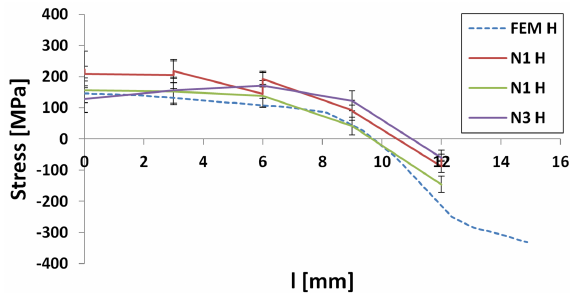
Figure 16. Hoop stress—central plane.